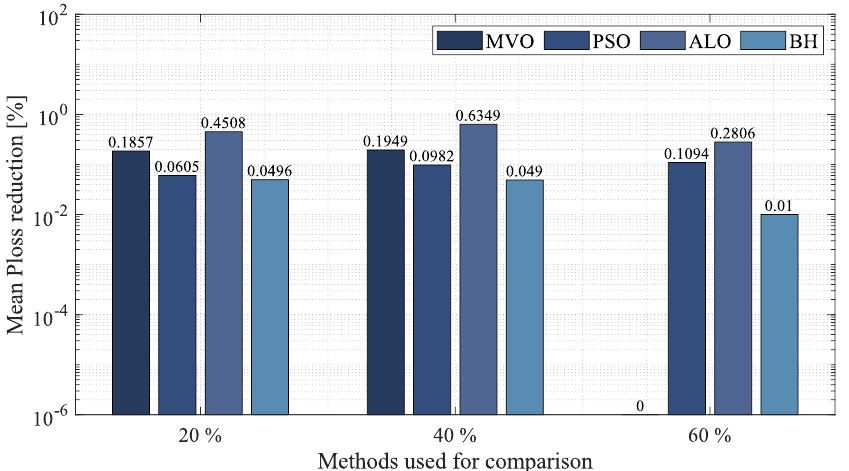
Figure 10. Percentage of reduction of average power losses obtained by the MVO in the 33-node radial test system compared to other methodologies.